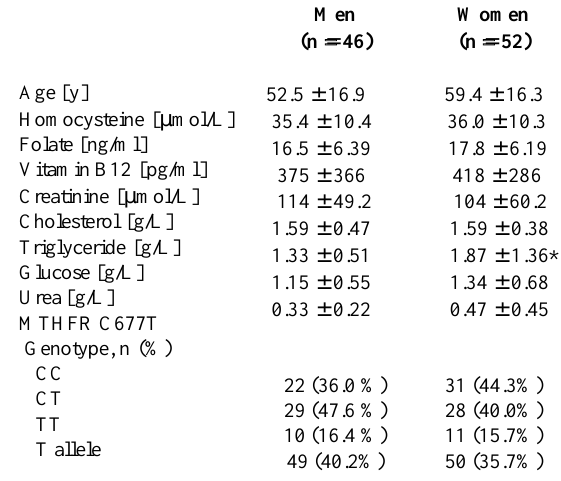
Table 1. Characteristics and methylenetetrahydrofolate reductase (MTHFR) C677T genotype distribution in the group of patients with CVD according to gender. * p =